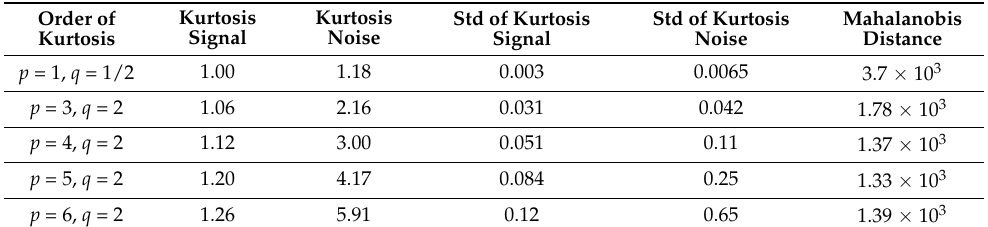
Table 5. Mahalanobis distance between the estimates of moments k p 1 q 1 and k p 2 q 2 characterizing the kurtosis of signal and